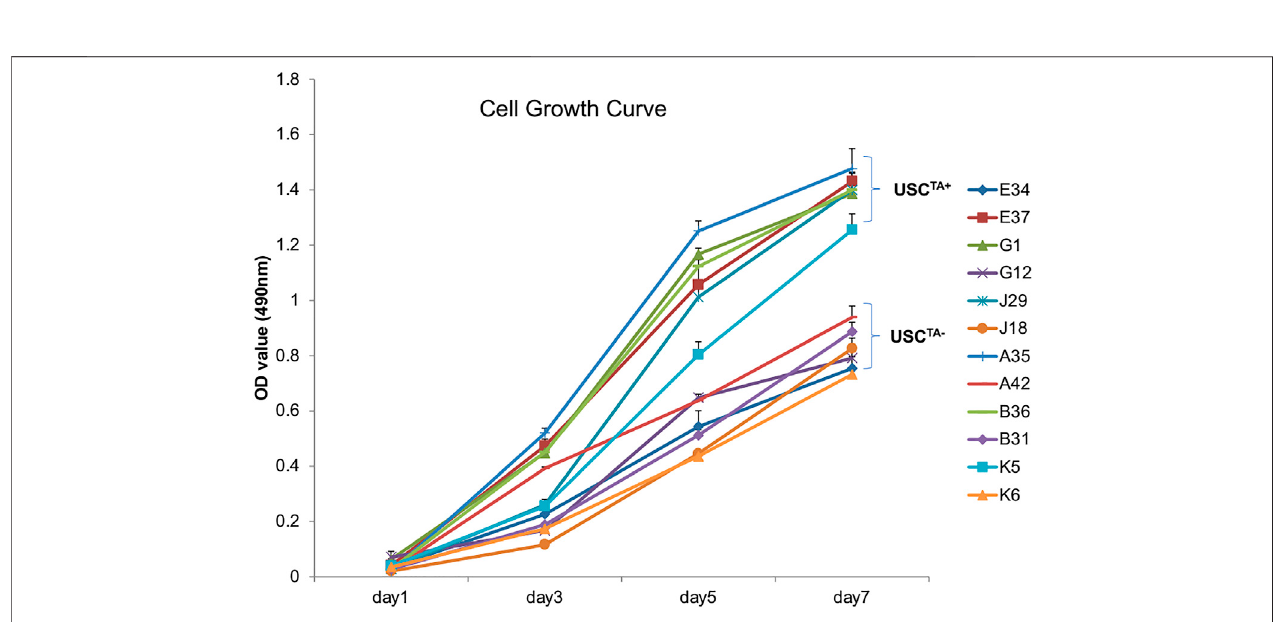
FIGURE4| Cell growth curve ofUSCs TA+ vs. USCs TA − . Cellproliferationwasmeasured astheUSCs werecultured for 7 days.SixindividualUSC TA+ clones ( n =6, p3, A35, B36, G1, E37, J29, and K5) generated signi fi cantly more cells and grew faster than USC TA − clones ( n = 6, p3, A42, B31, G12, E34, J18, and K6).